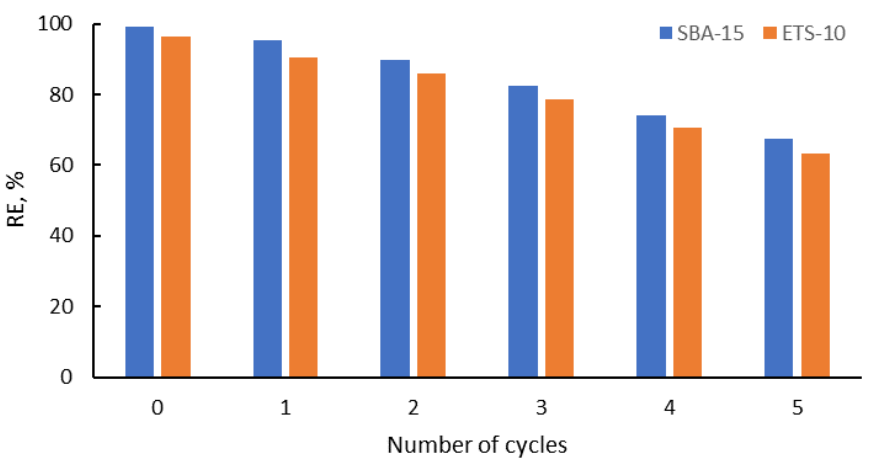
Figure 11. Reusability of the silica SBA-15 and titanosilicate ETS-10 in the removal of In(III). As can be seen, the adsorption capacity values of SBA-15 and ETS-10 decreased from 99.27% and 96.48% to 90.49% and 86.64% in the first cycle, and to 67.61% and 63.36% in the sixth cycle, respectively. The removal efficiency values decreased between 4% and 10% for SBA-15 from the first to the sixth cycle, and between 5% and 10% for ETS-10, respectively, and this showed that both the adsorbents could be regenerated and reused for the indium removal in multiple